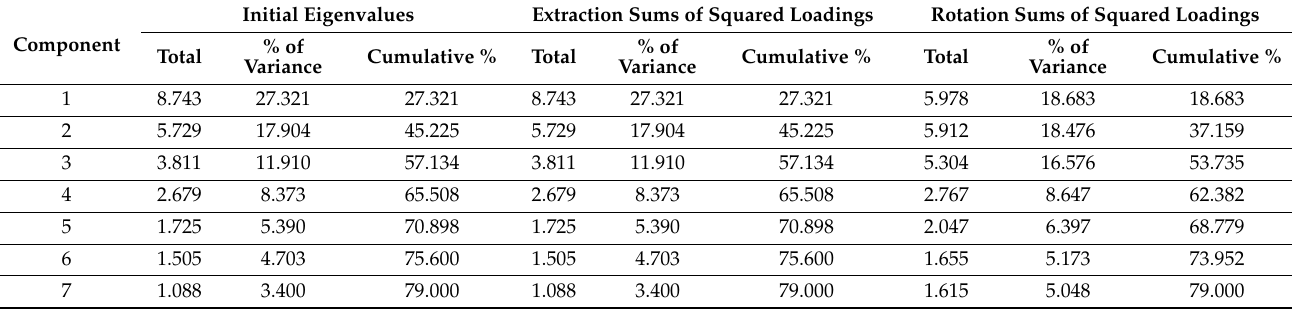
Figure 3. Scree plot used for identifying principal components. Table 4. Total variance